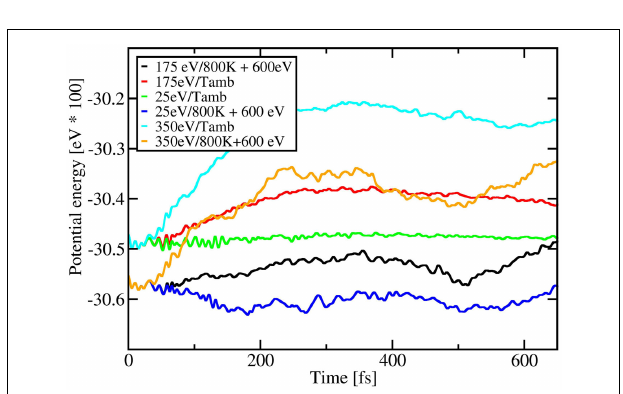
FIGURE 6 | Total interaction potential energy (eV*100) as a function of time (fs) for different kinetic energies (eV) and temperatures (K) . The potential energy curves for 800K are shifted up in energy by 600eV for the sake of